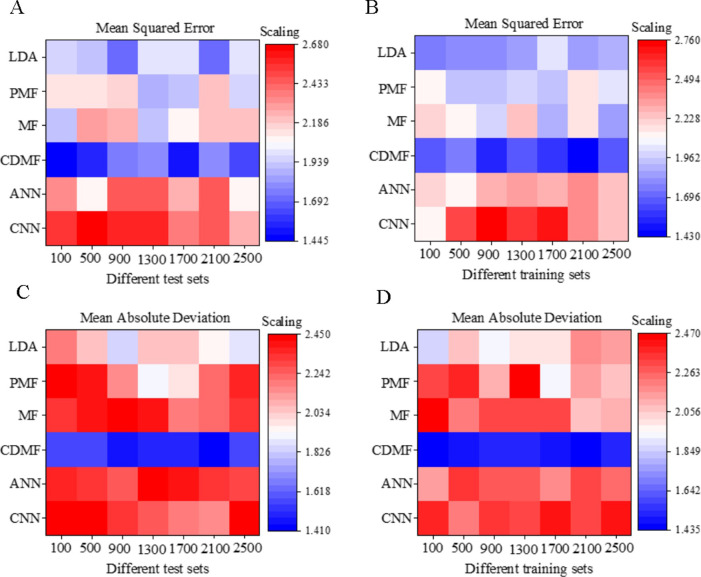
Performance analysis of MAE and MSE of different models.